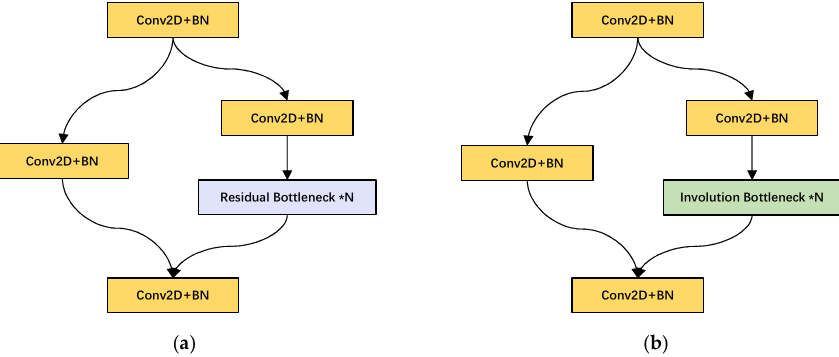
Figure 4. CSPLayer structure diagram. ( a ) is the original CSPLayer and ( b ) is the improved CSPLayer.